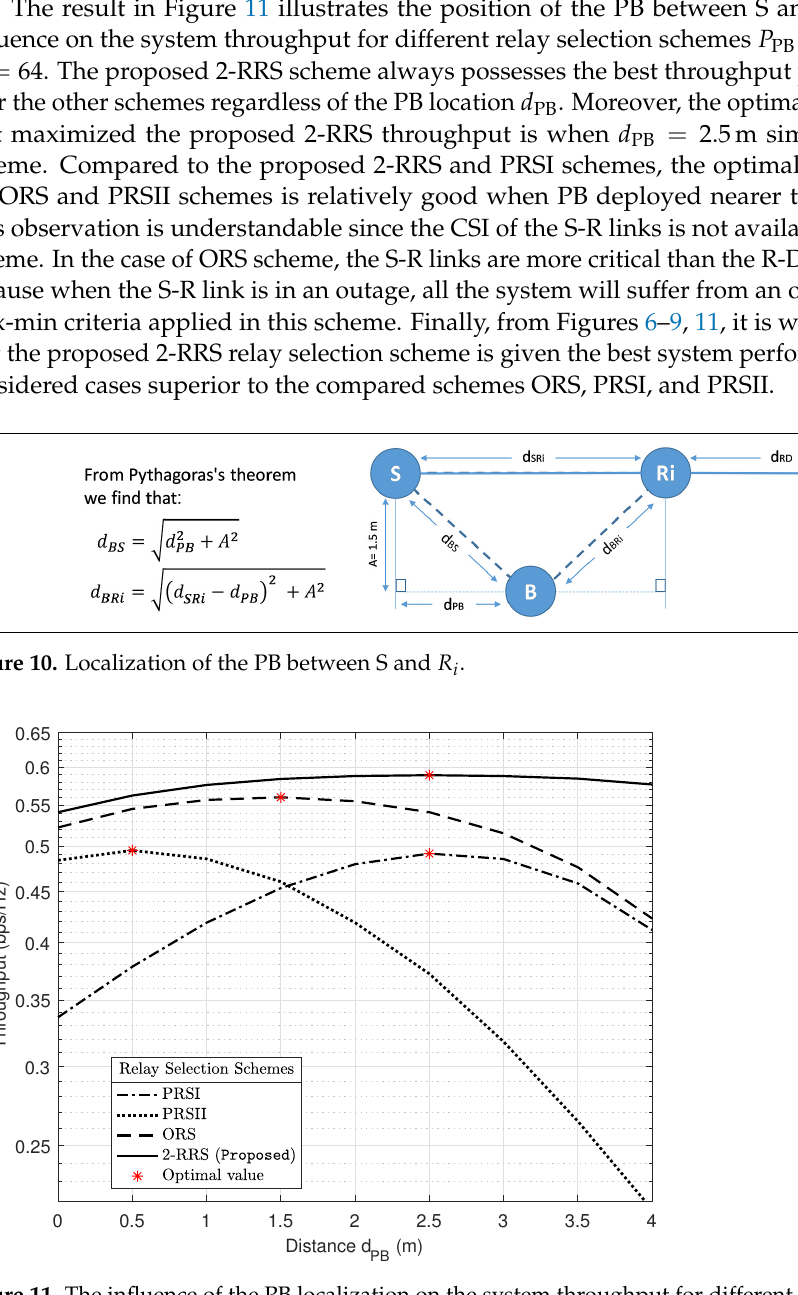
Figure 11. The influence of the PB localization on the system throughput for different relay selection schemes with P PB = 15dB and M =